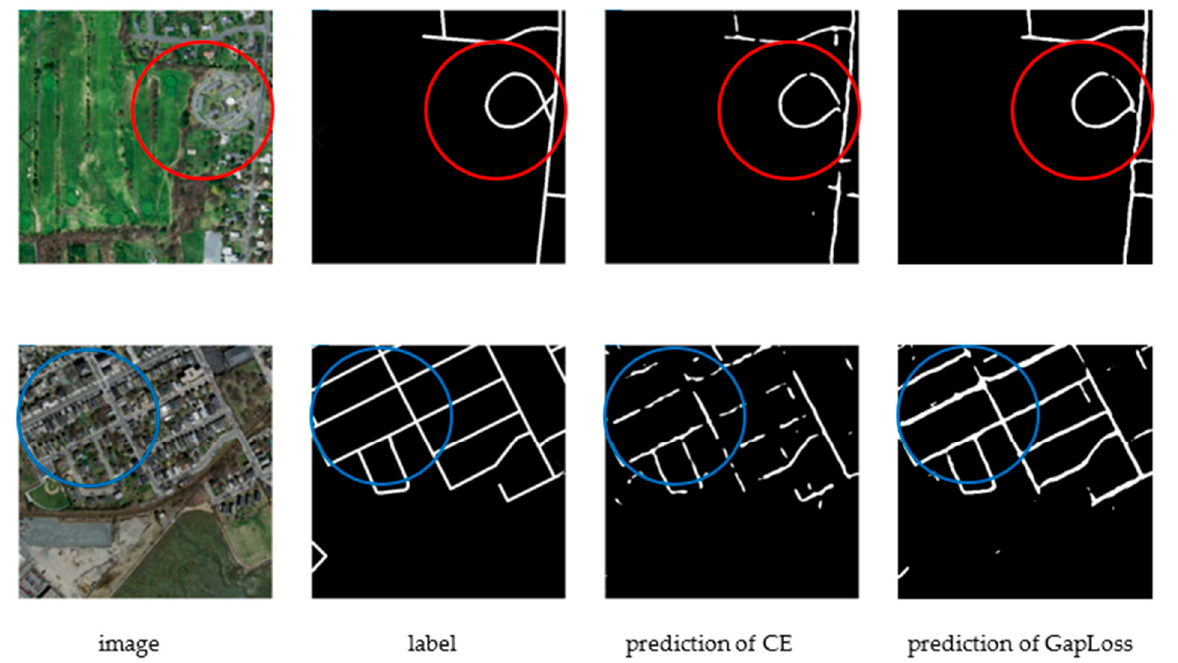
Figure 4. UNet++ results with CE and GapLoss on Massachusetts Roads Dataset. The blue and red circles indicate where the road continuity is improved after using GapLoss.